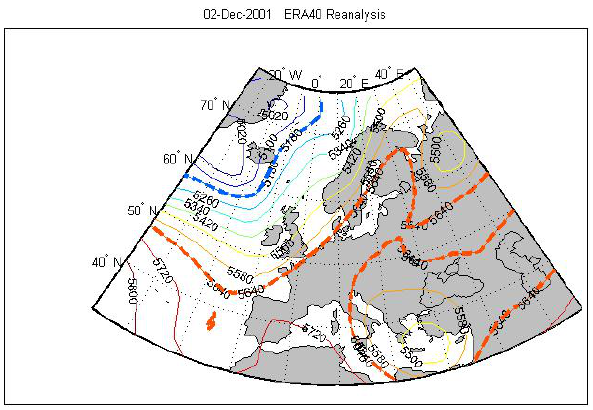
Fig.8. Typical pattern of Cluster 9: 2 December 2001 (units: gpm).